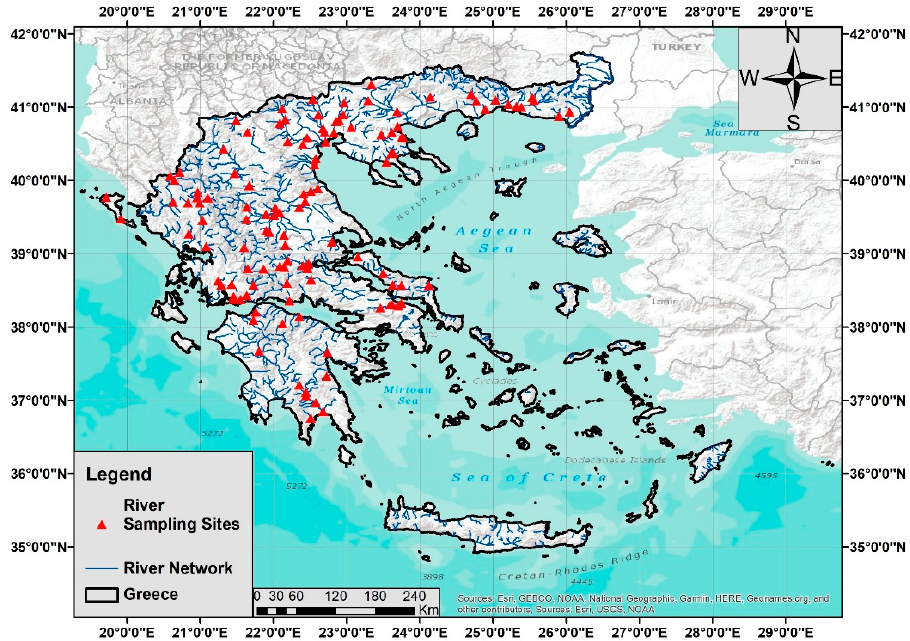
Figure 1. Location of the 122 sampling sites where the three hydromorphological methods were applied.